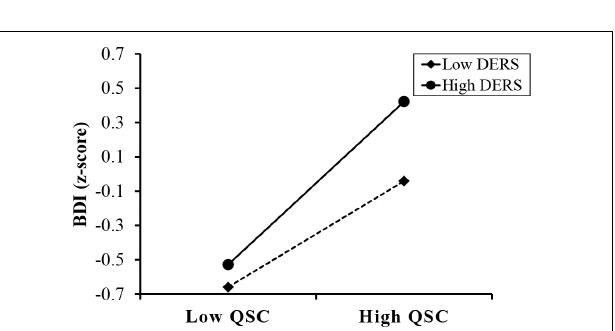
FIGURE 3 | Difficulties in emotion regulation moderates the effect of Qi-Stagnation Constitution on depressive scores. QSC, conversion score of the Qi-Stagnation Constitution Scale; DERS, total score of the Difficulties in Emotion Regulation Scale; BDI, depressive sore using Beck Depression